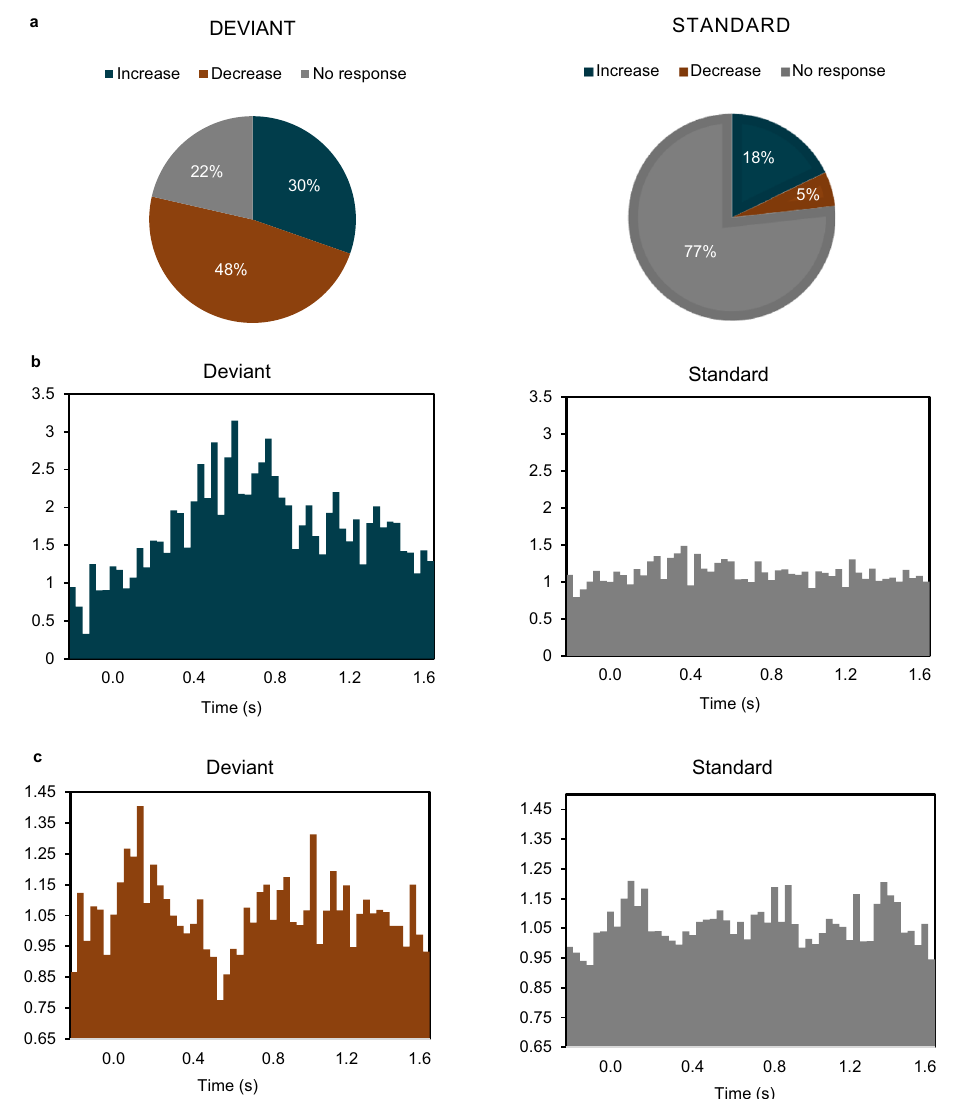
Fig. 3 Population average histograms for different neuronal responses to the task. a Pie charts show the motor thalamic neurons response to the auditory oddball task. The majority of the neurons (78%) responded to the deviant tones ( left ) whereas only 23% of the neurons showed a response to the standard tones ( right ). The population histograms are averages of the individual cell histograms that showed an increase ( b ) to the deviant tones (left) compared to the standard tones ( right ), and the neurons that showed a decrease in fi ring rate ( c